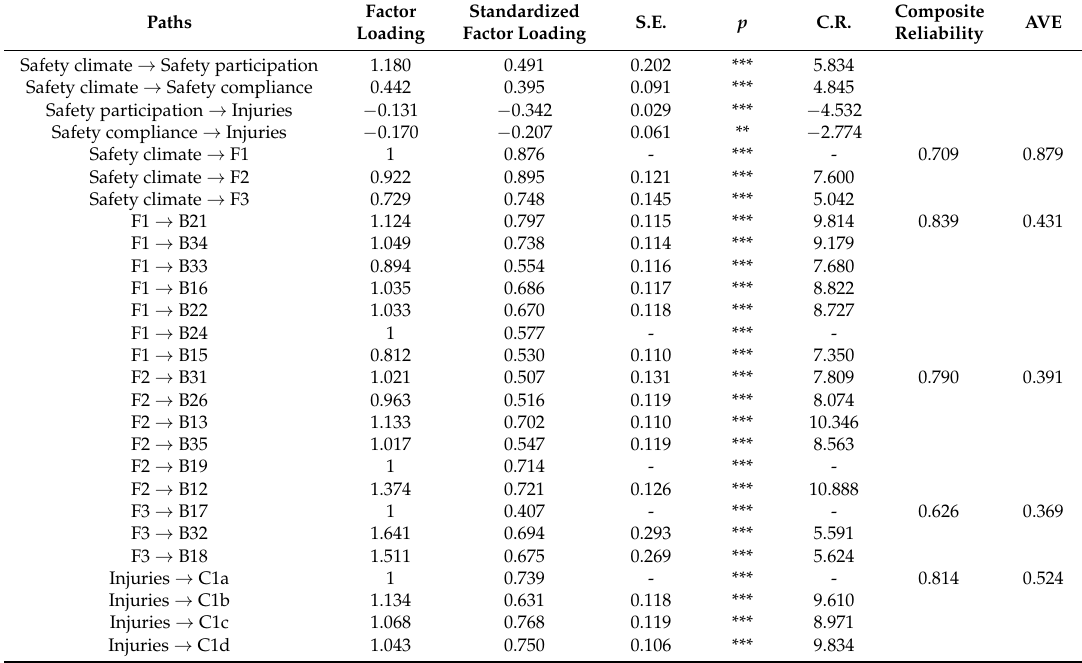
Table 5. Results of regression